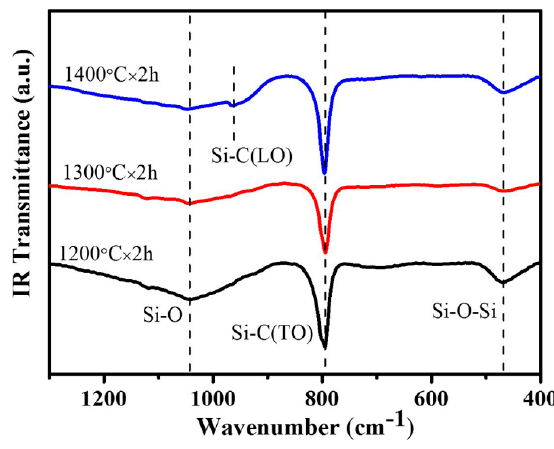
Figure 4. Fourier-transform-infrared spectroscopy (FT-IR) absorbance spectrum of the as-received samples.